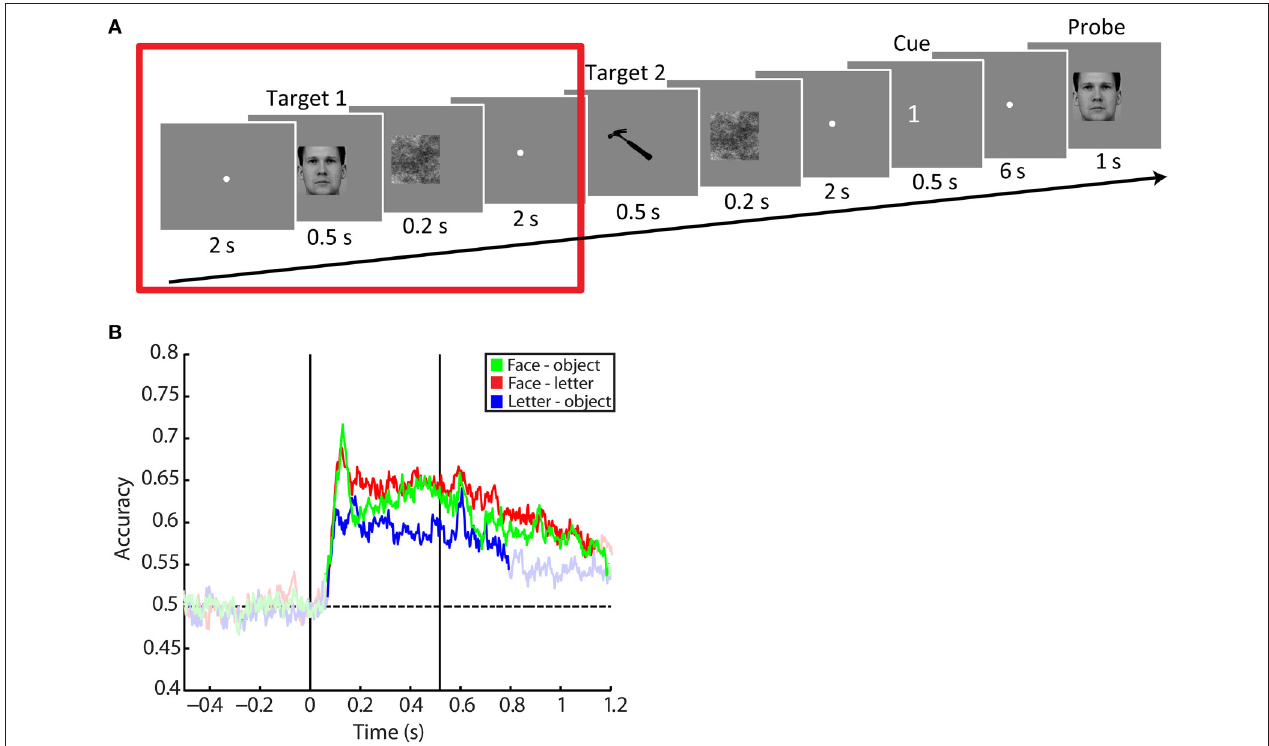
FIGURE 1 | Task design and accuracies over time. (A) Task design. Subjects were shown two images of different classes (faces, objects or letters) per trial. These images were followed by a delay period. After the second delay period a cue was presented, informing the subject which target stimulus had to be kept in memory. After a final delay period, the subject was probed with a same-difference task. In this study we only used data of the period around the presentation of the first target, depicted as the period enclosed by the red square. All presentation timings were in reality 16.7ms longer than depicted due to a fixed delay in stimulus presentation. The face image belongs to the KDEF dataset (M64; Lundqvist et al., 1998), the tool image is part of the BOSS set (Brodeur et al., 2010; CC BY-SA 3.0). (B) Averaged accuracy traces for the face-letter (green), face-object (red), and letter-object (blue) contrasts. The first black vertical line indicates stimulus onset, the second line coincides with stimulus offset. Bright colors indicate accuracies significantly above the accuracies obtained at baseline (before stimulus onset). We only tested post-stimulus onset accuracies against baseline. The dashed vertical line denotes the chance-level value of